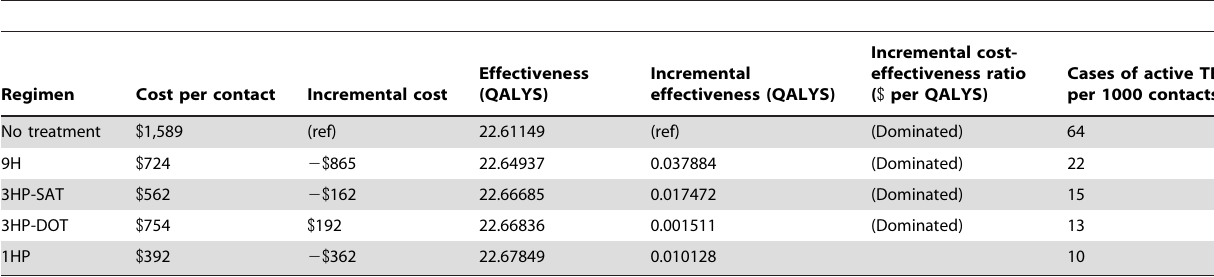
Table 5. Costs, effectiveness, and incremental cost-effectiveness ratios for the four drug regimens in order of increasing effectiveness, referenced to the strategy of ‘‘no treatment.’’